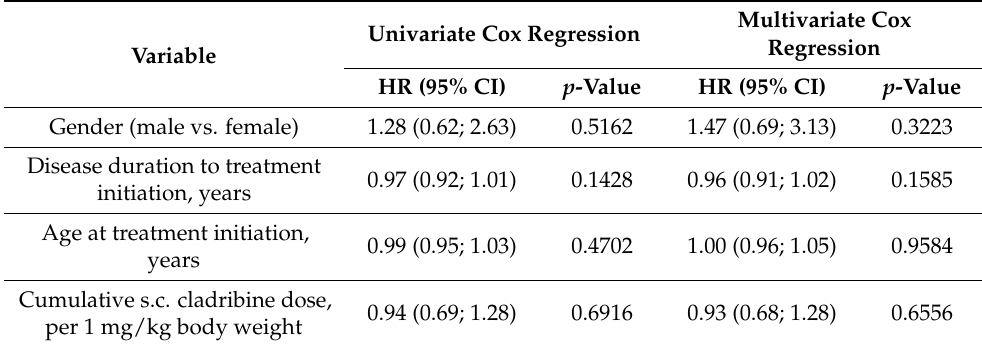
Table 3. Univariate and multivariate analyses of factors influencing time to EDSS score progression.